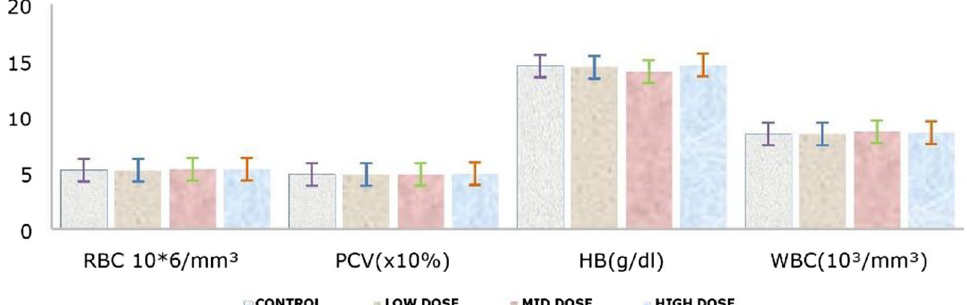
Fig. 7 Changes of Wistar albino rat’s food intake (g/day) exposed to TRV. NS—not significant, **( p > 0.01), *( p > 0.05), n (one-way ANOVA followed by Dunnett’s test). Note Trichoderma viride fungal crude extract